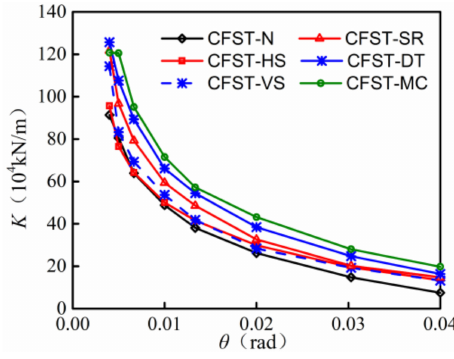
Figure 11. Stiffness degradation. Table 5. Secant rigidity at each drift